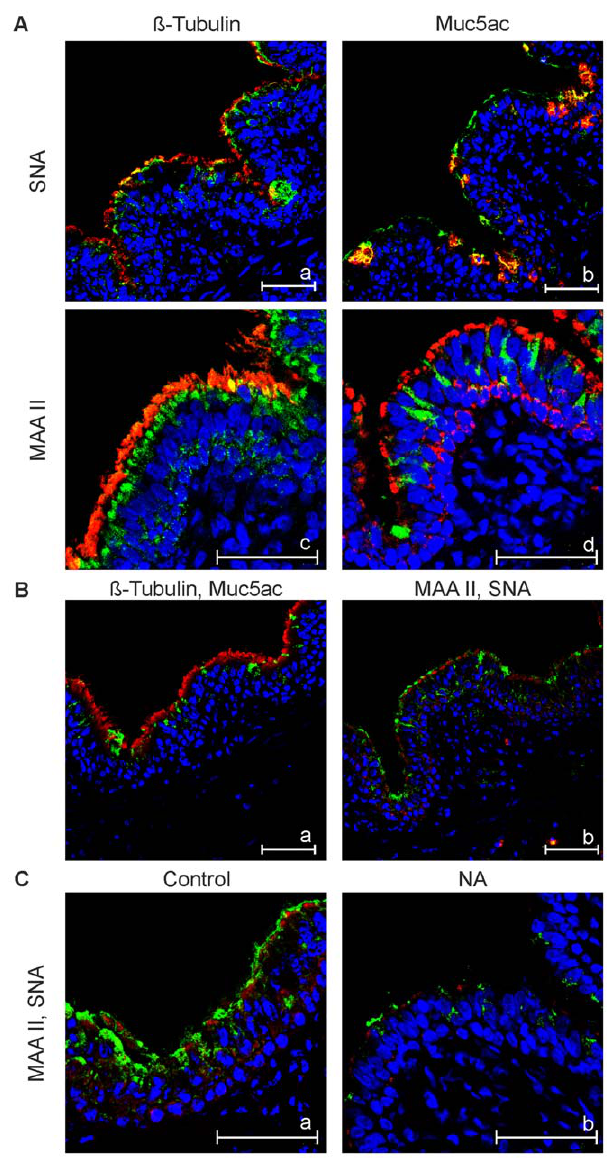
Figure 3. Expression of sialic acid in swine PCLS cells. Sialic acids were detected by lectin staining: MAA ( Maackia amurensis agglutinin ) for a 2,3-linked sialic acids and SNA ( Sambucus nigra agglutinin ) for a 2,6- linked sialic acids. Ciliated cells were stained using an anti- b -tubulin antibody and mucus-producing cells were stained using an anti muc5ac antibody. In panels A, lectin-staining is compared with staining of ciliated (red) or mucus-producing cells (red in Ab, green in Ad); SNA staining is shown in green (Aa and Ab), MAA staining is shown in green (Ac) or red (Ad). In Ba, co-staining of ciliated (red) and mucus-producing cells (green) is shown; Bb shows co-staining with MAA (red) and SNA (green). In C samples were co-stained SNA (green) and MAA (red); cryosections were derived from PCLS before (Ca) or after neuraminidase treatment (Cb).